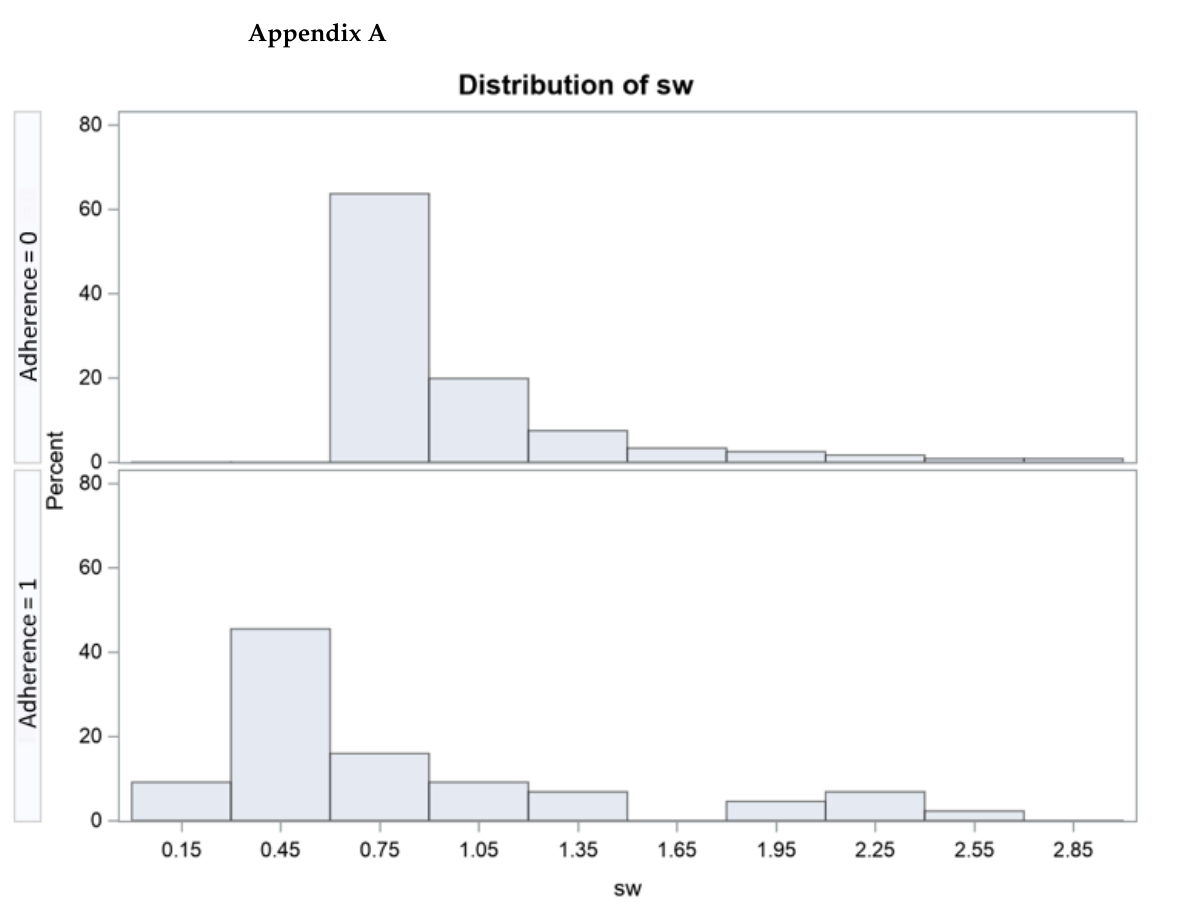
Figure A1. Distribution of weighting in pseudo-population according to ESCMID recommendations adherence.